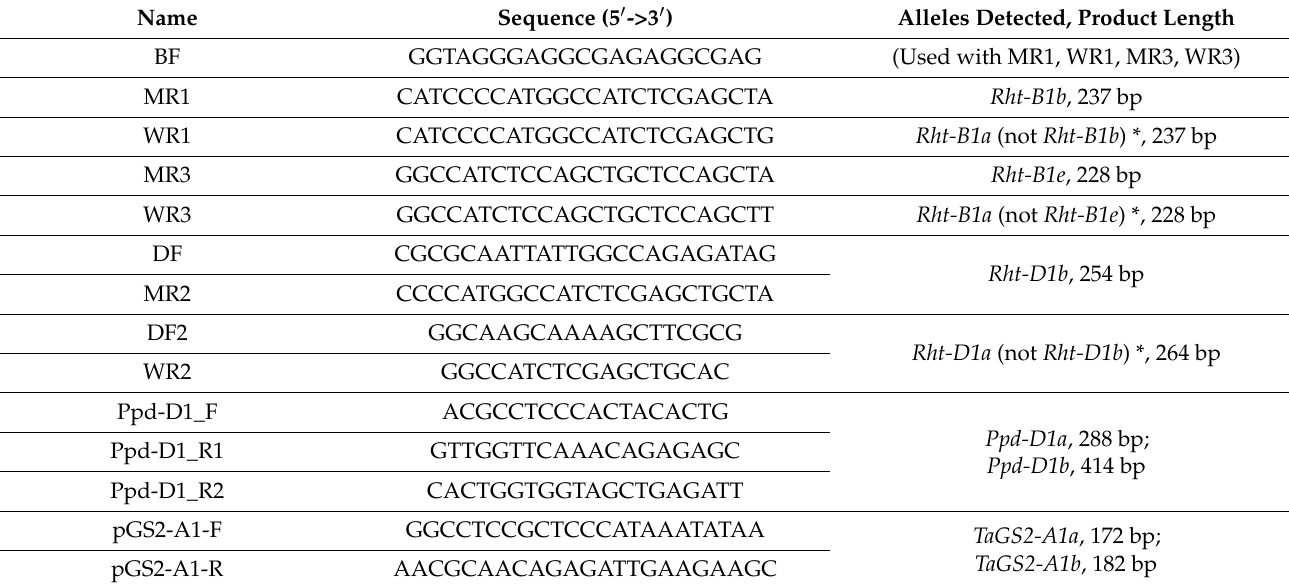
Table 1. The primers used for the PCR